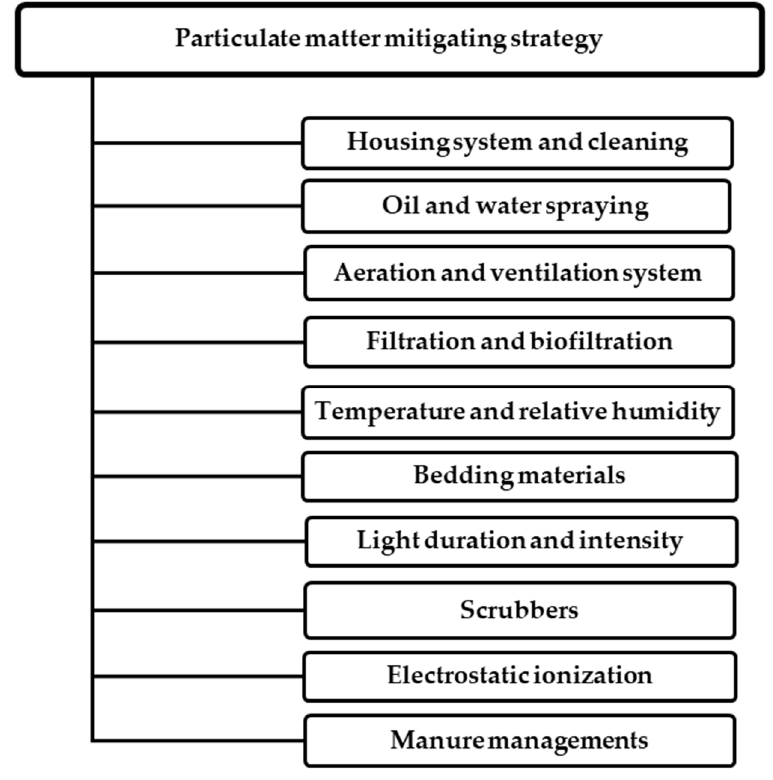
Figure 3. Overview of the PM emission mitigating strategy used in poultry housing.